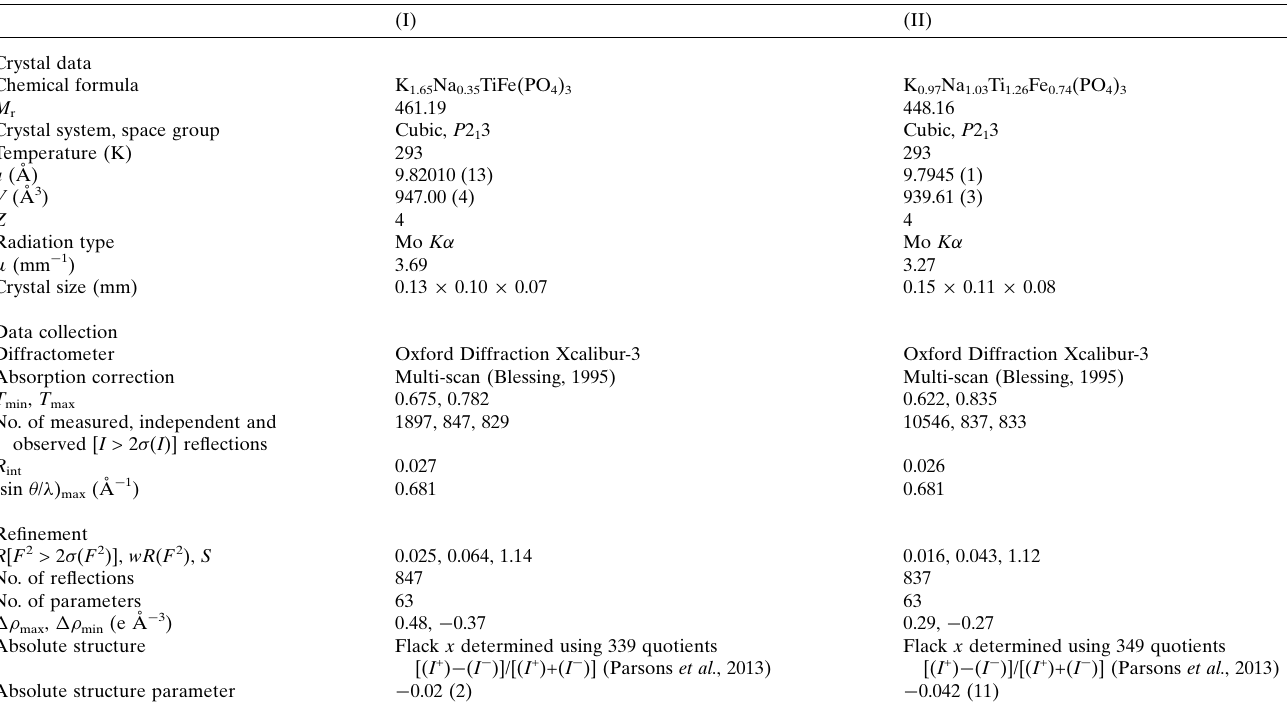
Table 3 Experimental